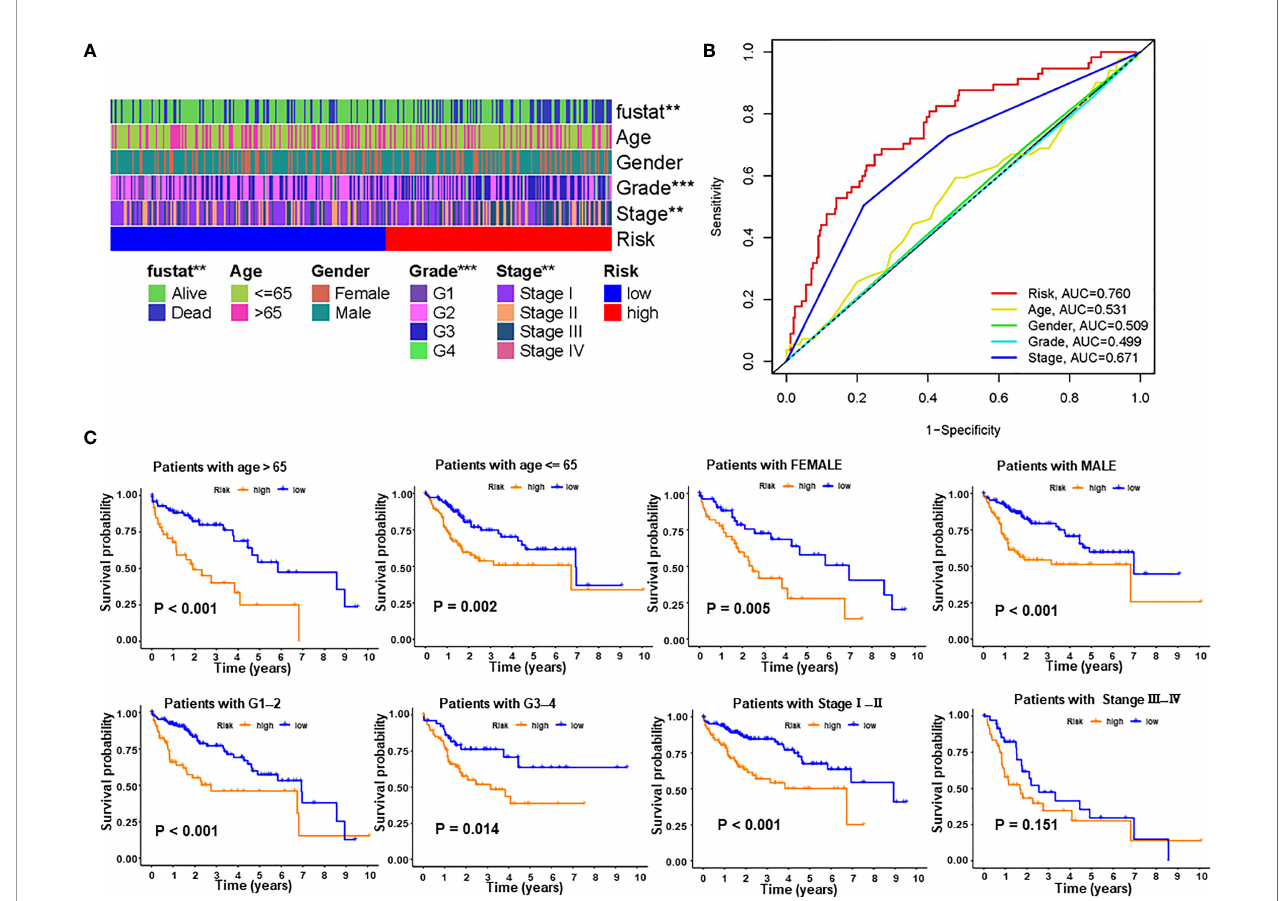
FIGURE 5 | Correlations between risk score and different clinicopathological characteristics of HCC in the entire cohort. (A) Strip chart showing relationships between clinical characteristics and PRlncSig score. (B) ROC analysis of 3-year overall survival for multiple prognostic indicators of HCC samples. (C) Clinical strati fi cation analysis of overall survival of patients with HCC in the high- and low-risk groups by age, gender, histological grade, and tumor stage. ** P < 0.01, *** P <